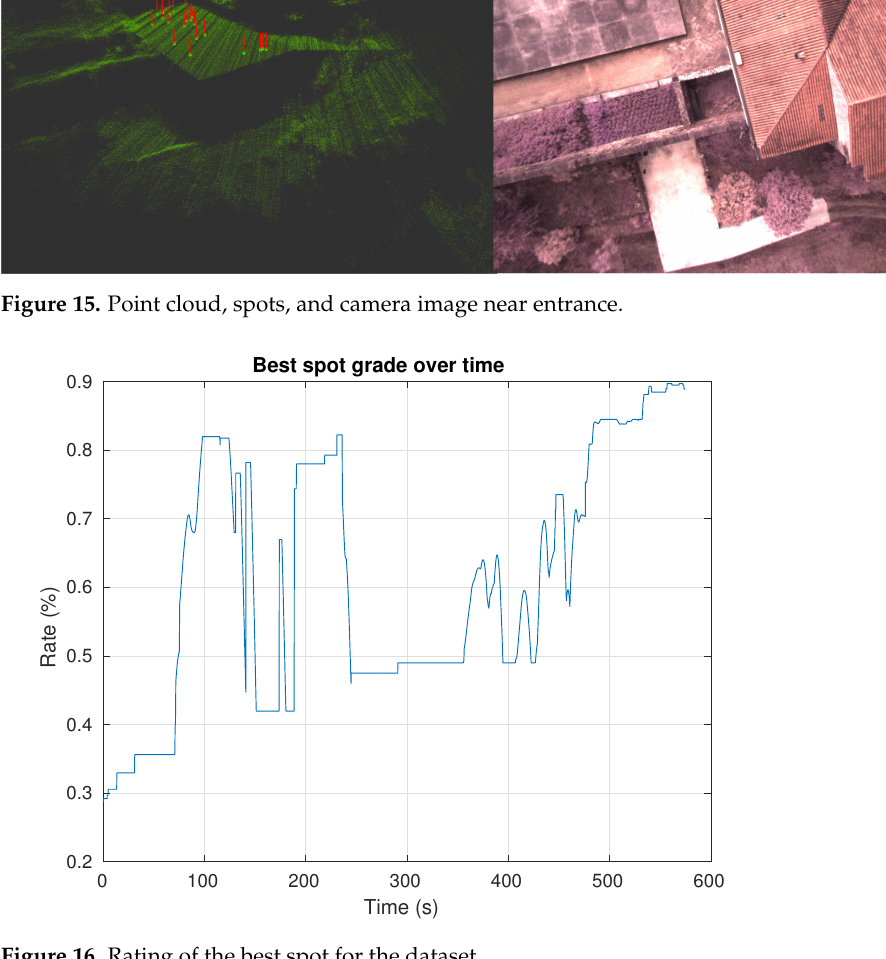
Figure 16. Rating of the best spot for the